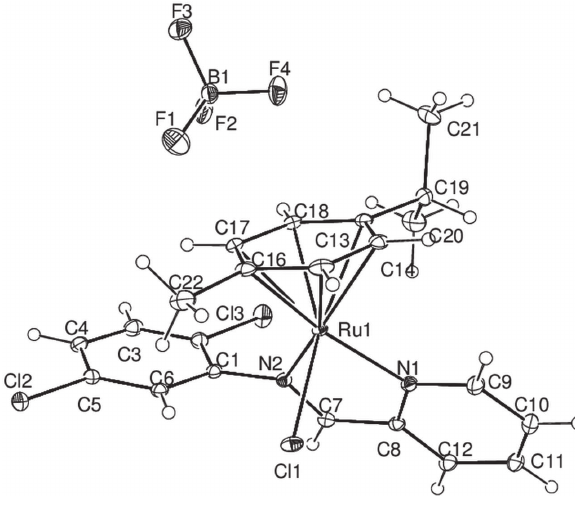
Table 1: Data collection and